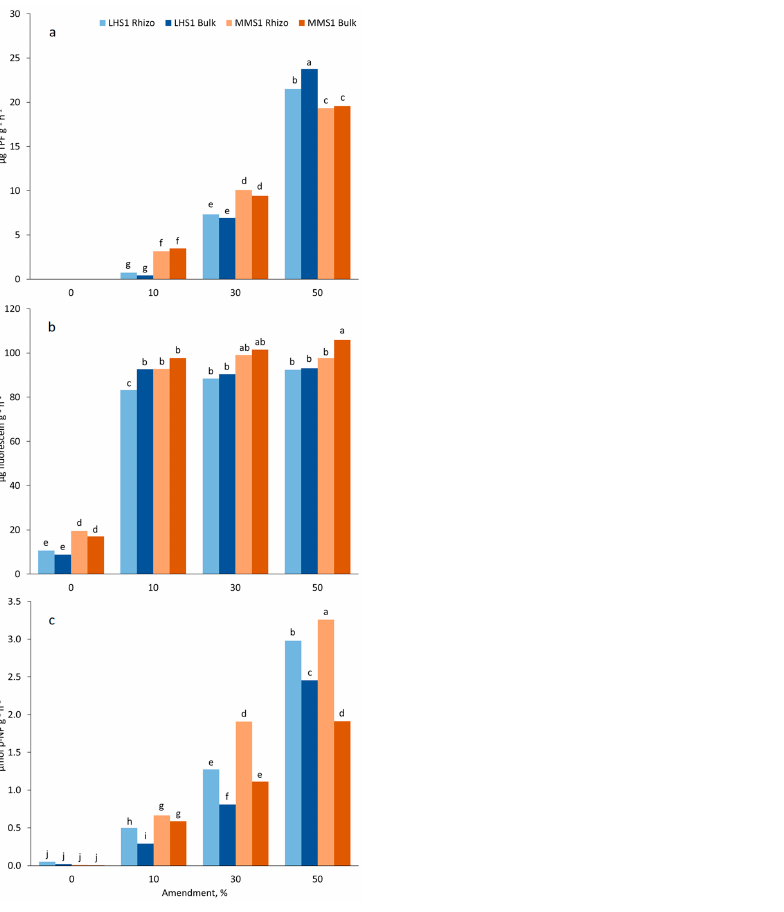
Figure 3. Interaction of simulant, manure concentration and Rhizo vs. Bulk soil on ( a ) dehydrogenase; ( b ) fluorescein diacetate hydrolysis; and ( c ) alkaline phosphomonoesterase activity. Bars with different letters are different for p < 0.05 at the post hoc Duncan’s mean separation test.